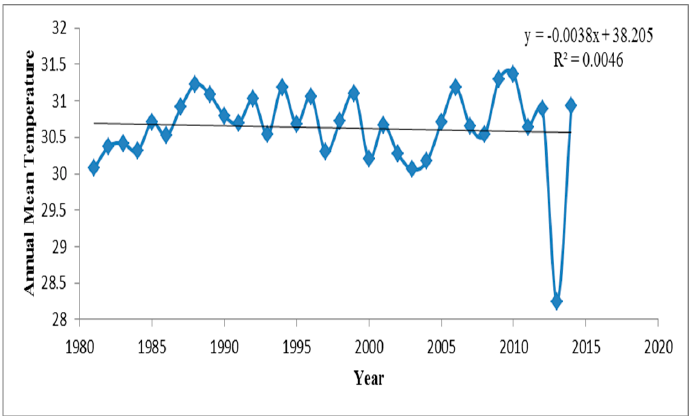
Figure 7. Trend of maximum temperature (0 °C) of Bogra station (1981–2015). 3.3. Community Risk and Vulnerability Analysis The present study area was the active Brahmaputra-Jamuna (AEZ-7) floodplain, and it encompasses the belt of unstable alluvial land along with the Brahmaputra-Jamuna River, where the land is continually being formed and eroded by shifting river channels. In this area, river flooding is the most dominant hazard, and people are facing riverbank erosion and floodwater inundation during monsoons. These phenomena damage their homestead, livestock, agriculture crop, livelihood, drinking water availability, sanitation, and health. Unpredictable river bank erosion is the main community risk and is creating pressures to the key communities such as agricultural farmers, crop farmers and wage labourers. The key communities are now at the risk of vulnerabilities regarding increased sedimentation and erosion rate, irregular rainfall pattern,abrupt temperature changes and increased use of agrochemicals as well as pest invasion. The vulnerabilities of the study area have been depicted from the DPSIR framework (Figure 8). Therefore, the current risk and vulnerabilities of the study area have been given in Table 3. Consequently, riverbank erosion is the most commanding peril for agriculture practices because 178.76 hectares of land was eroded in 2011 [9], and many of the ancient inhabitations have been rendered extinct by riverbank erosions. Moreover, the study area has also suffered from heat waves during summer, and in the last decade a new natural hazard, namely cold waves, have added to their sufferings [16]. Also, ground water levels have declined due to increased evapotranspiration which depletes the moisture and diminishes the organic matter from the topsoil. In response, to reduce the erosion of the study area, the Jamuna-Brahmaputra flood protection dam, known as the Water and Power Development